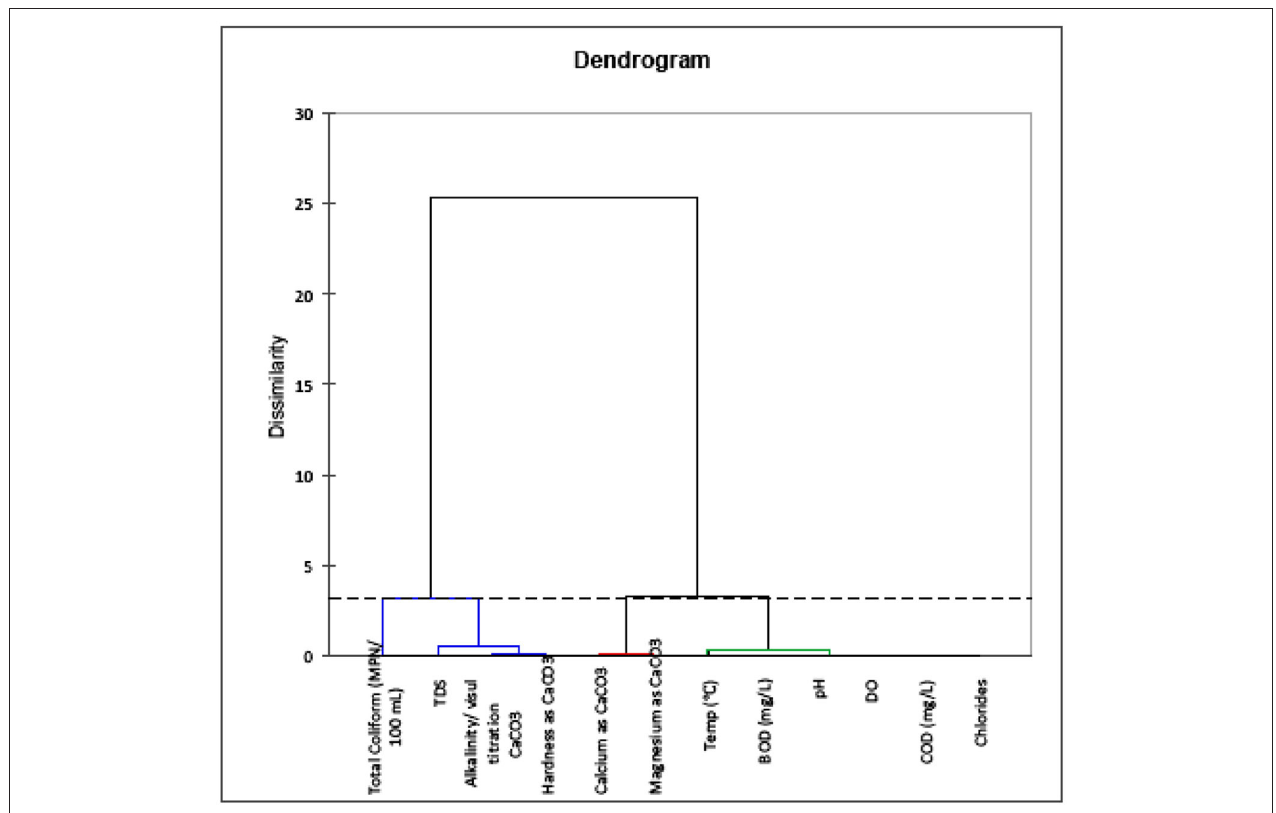
FIGURE 12 | Dendrogram for physicochemical parameter mean values for 2017, 2018, and 2019.